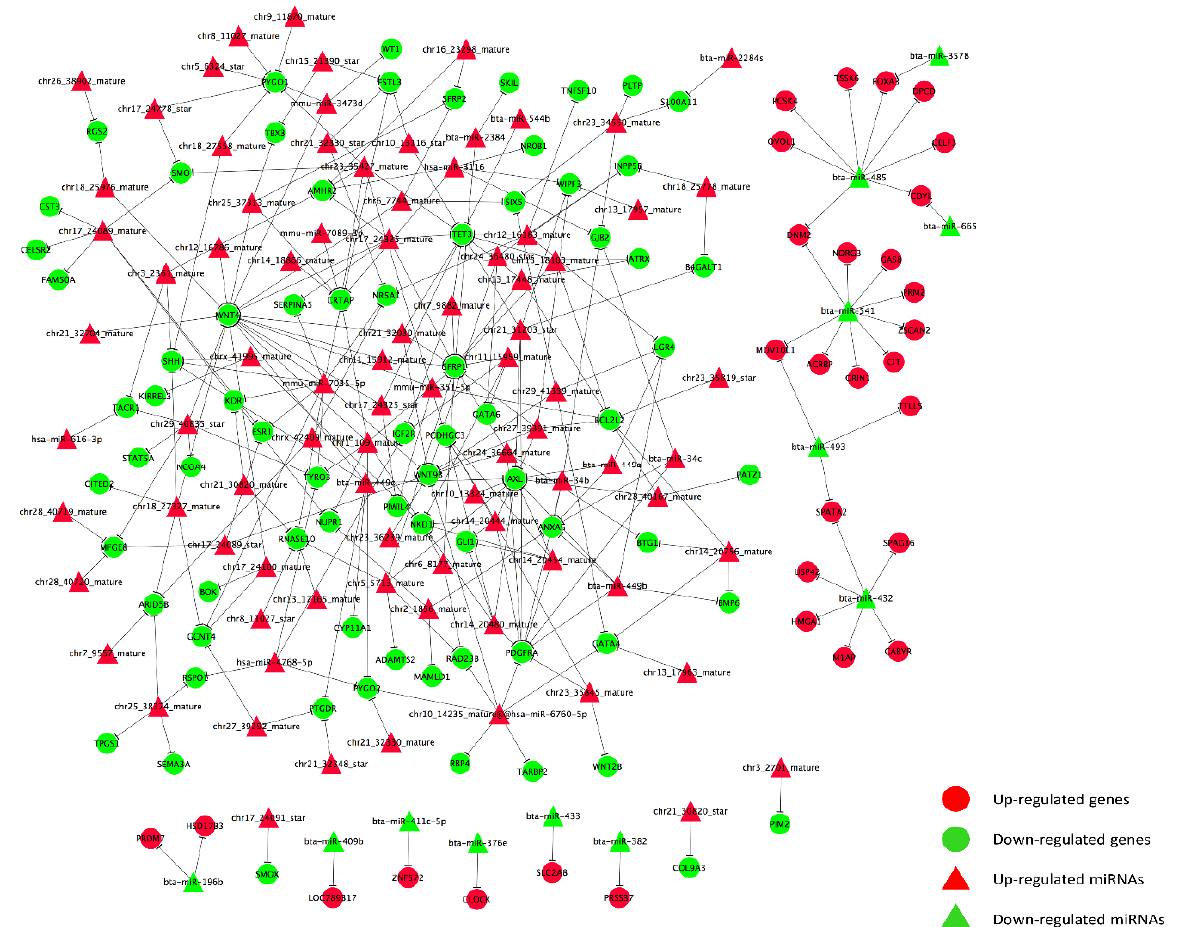
Figure 4. Network of miRNAs and target genes prediction and annotation analyses. Green triangles: Downregulated miRNAs; Red triangles: Upregulated miRNAs; Green circles: Downregulated genes; Red circles: Upregulated